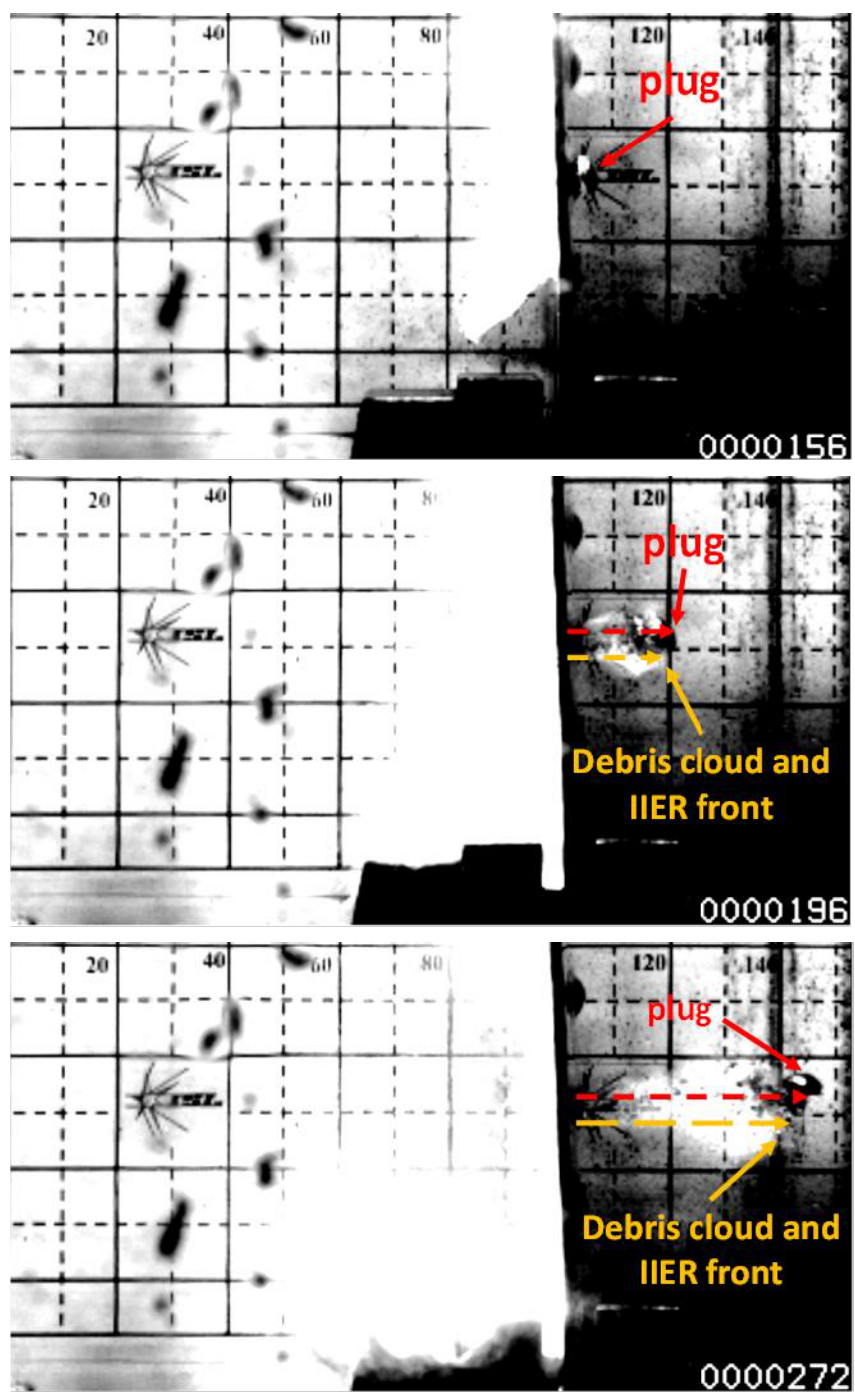
Figure 3. 5 mm MRE fragment impacting 2 mm plate at 889 m/s. Estimated residual velocity of 325 m/s.